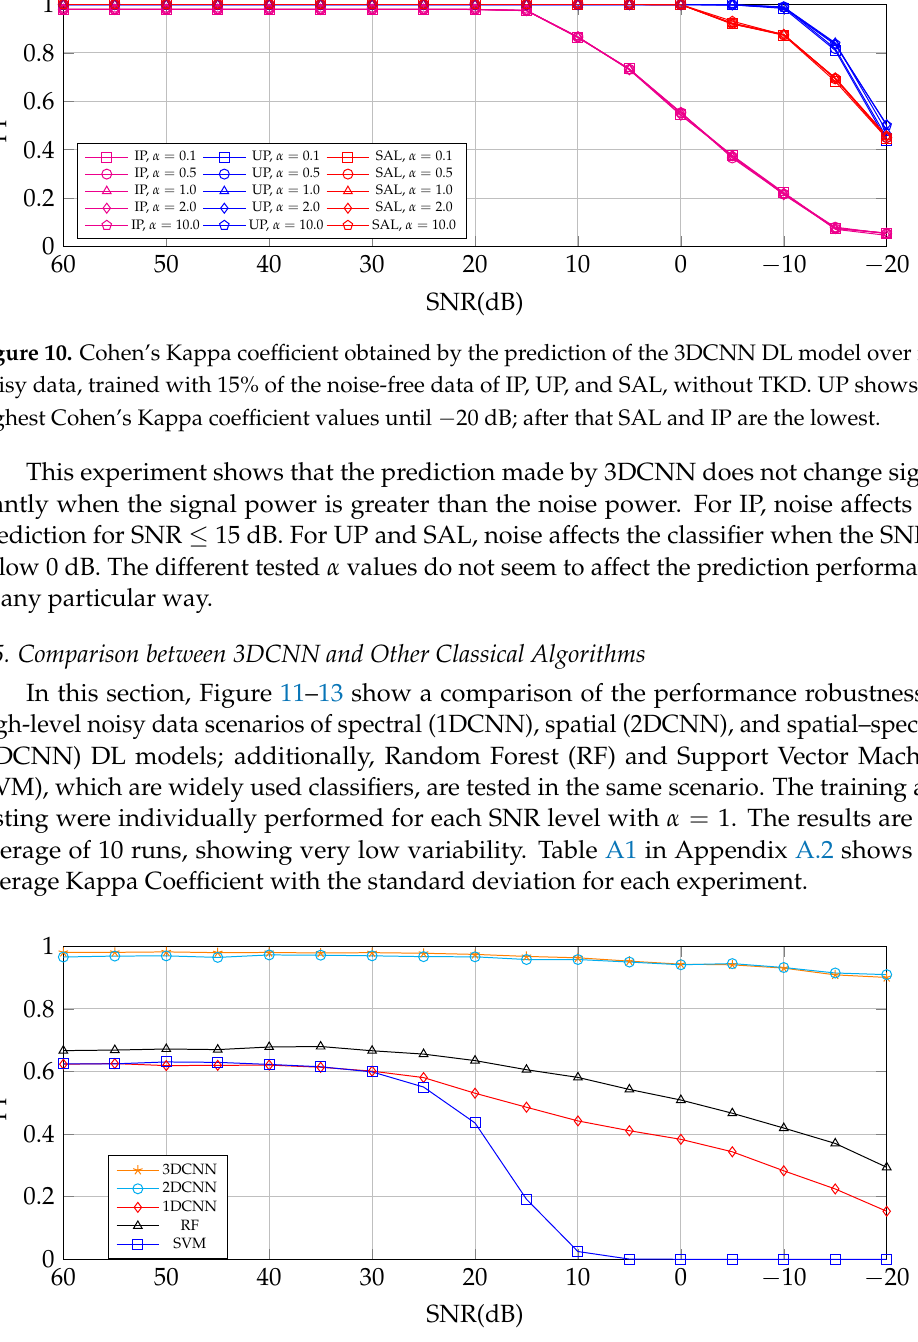
Figure 11. Indian Pines. Cohen’s Kappa coefficient obtained by different classifiers for IP HSI compressed with TKD to 40 tensorial bands training with 10% of TS. The best performance is achieved by 3DCNN and 2DCNN, then RF, 1DCNN, and SVM in descending